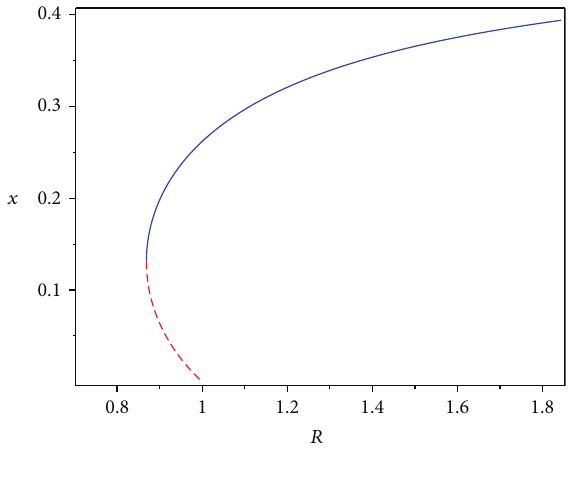
Figure 3: Bifurcation diagram of system (4) near 𝑃 ∗ in the plane of 𝜇 𝜇 1 and 2